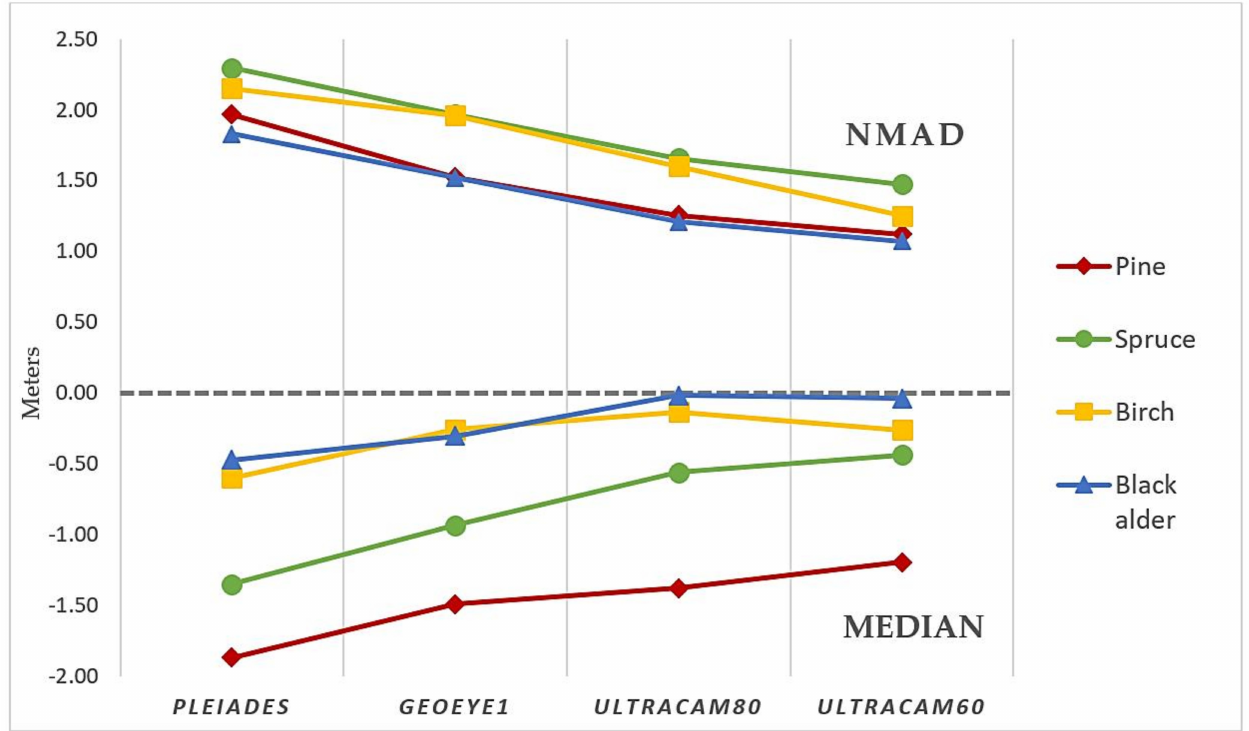
Figure 7. The Summary statistics of the best image-derived DSMs compared to the LiDAR individual canopy peaks, based on two vertical accuracy measures (median error and NMAD) and separated by four main vegetation species. Values are in metres. Negative values represent an underestimation of image-derived